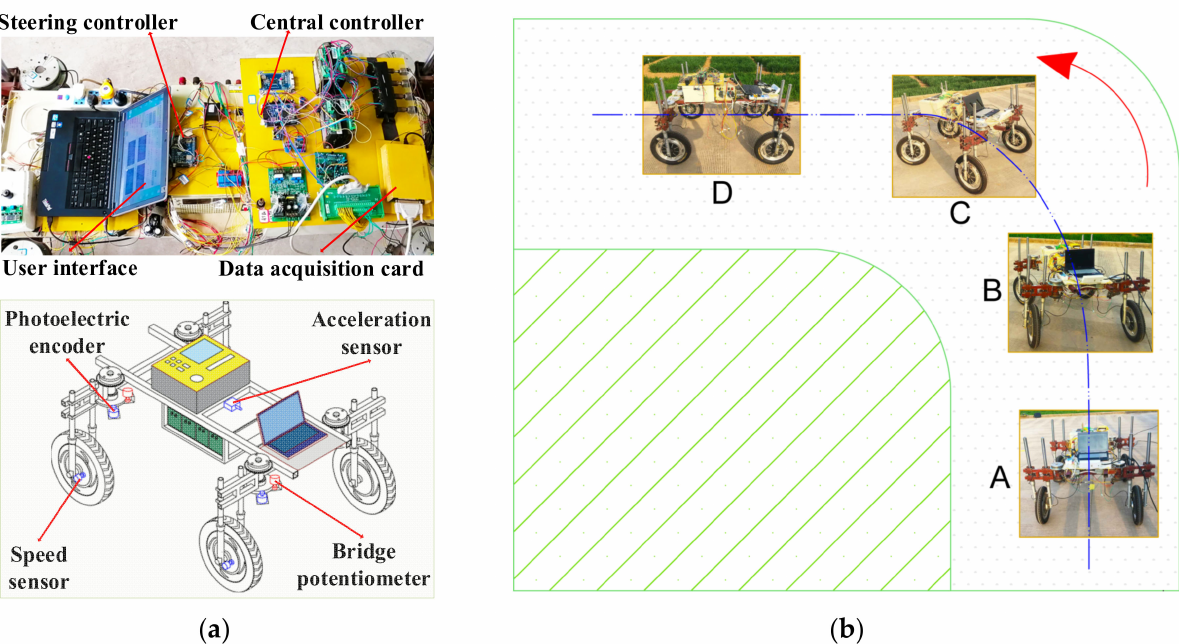
Figure 12. Test scenes of the road tests: ( a ) composition of the prototype system; ( b ) motion scene of steering